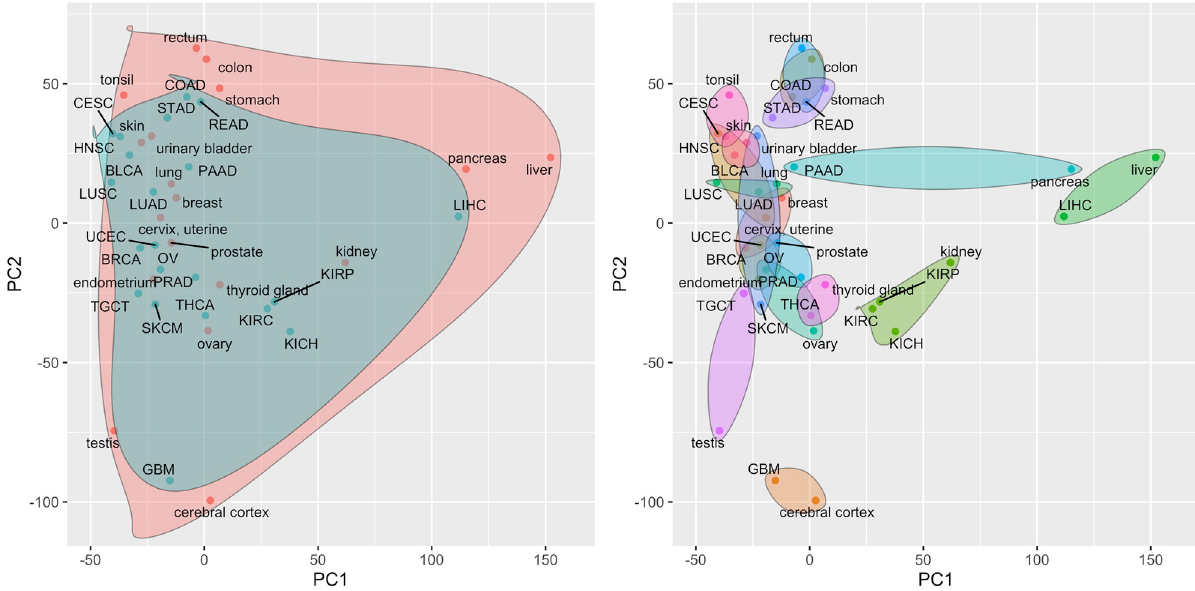
Fig 2. Projection of TCGA cancer types and associated HPA normal tissues onto the first two principal components of the tissue/cancer-specific mean expression values. Principal components are computed from a matrix of tissue-specific and cancer-specific mean gene expression values, i.e., a matrix containing all c � and n � statistics. a) Cancers are represented by blue points and are enclosed in the blue shaded region; normal tissues are i ; j i : j represented by red points and are enclosed in the red shaded region. b) Each normal tissue and the associated cancer type(s) are enclosed in a separate shaded region.